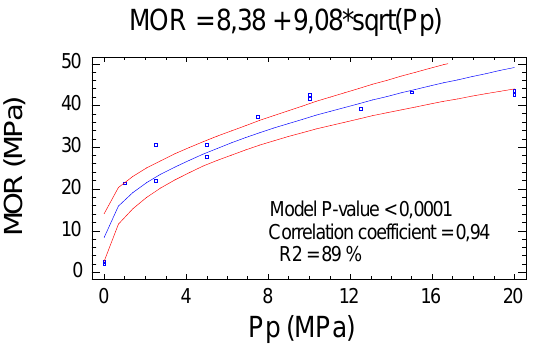
Figure 4. Influence of Pp on the modulus of rupture (MOR).